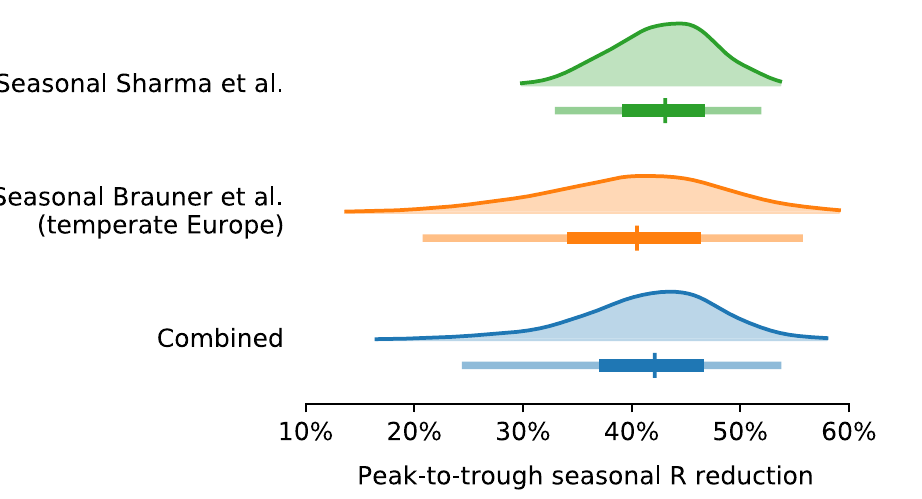
Fig 3. Posterior distributions of the R reduction on July 1 relative to January 1 with median, 50% and 95% credible intervals.